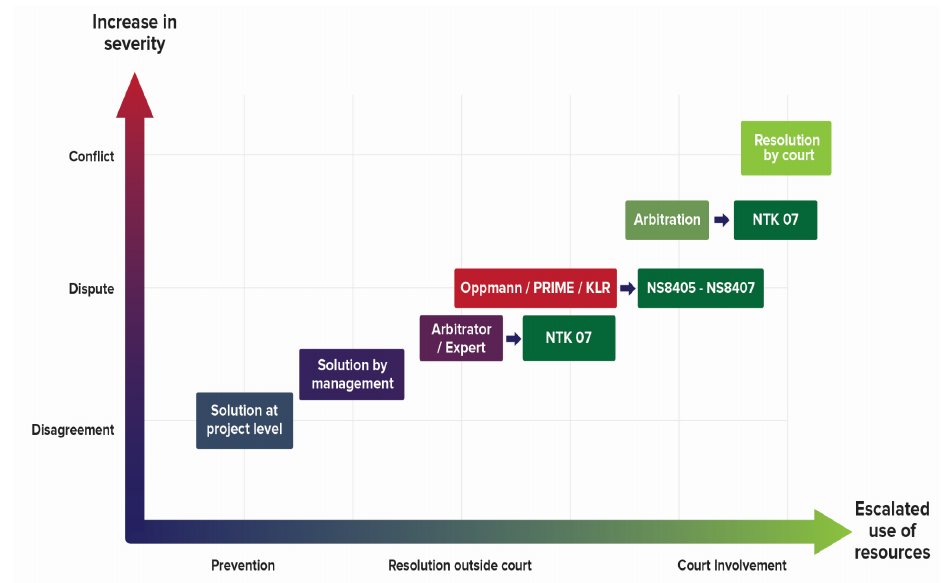
Figure 2. Development of the use of resources in construction conflicts; reproduced and updated [29] .